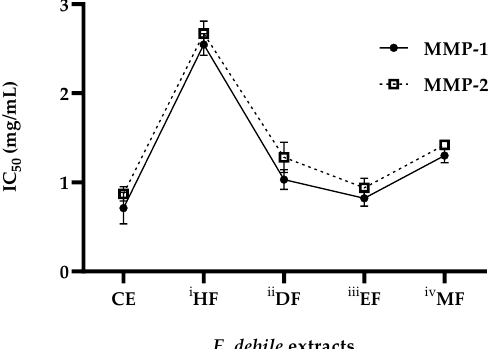
Figure 8. Anti-collagenase activities of E. debile extracts. i–v Successive partition of crude extract (CE) (10.45 ± 1.20 g) into hexane fraction (HF), dichloromethane fraction (DF), ethyl acetate fraction (EF), methanol fraction (MF), and methanol insoluble residue (MR). Anti-collagenase activities were expressed as IC 50 (the half maximal inhibitory concentration) of MMP-1 and MMP-2, which are the matrix metalloproteinase type 1 and 2, respectively. All data are presented as mean ± SD of triplicates.